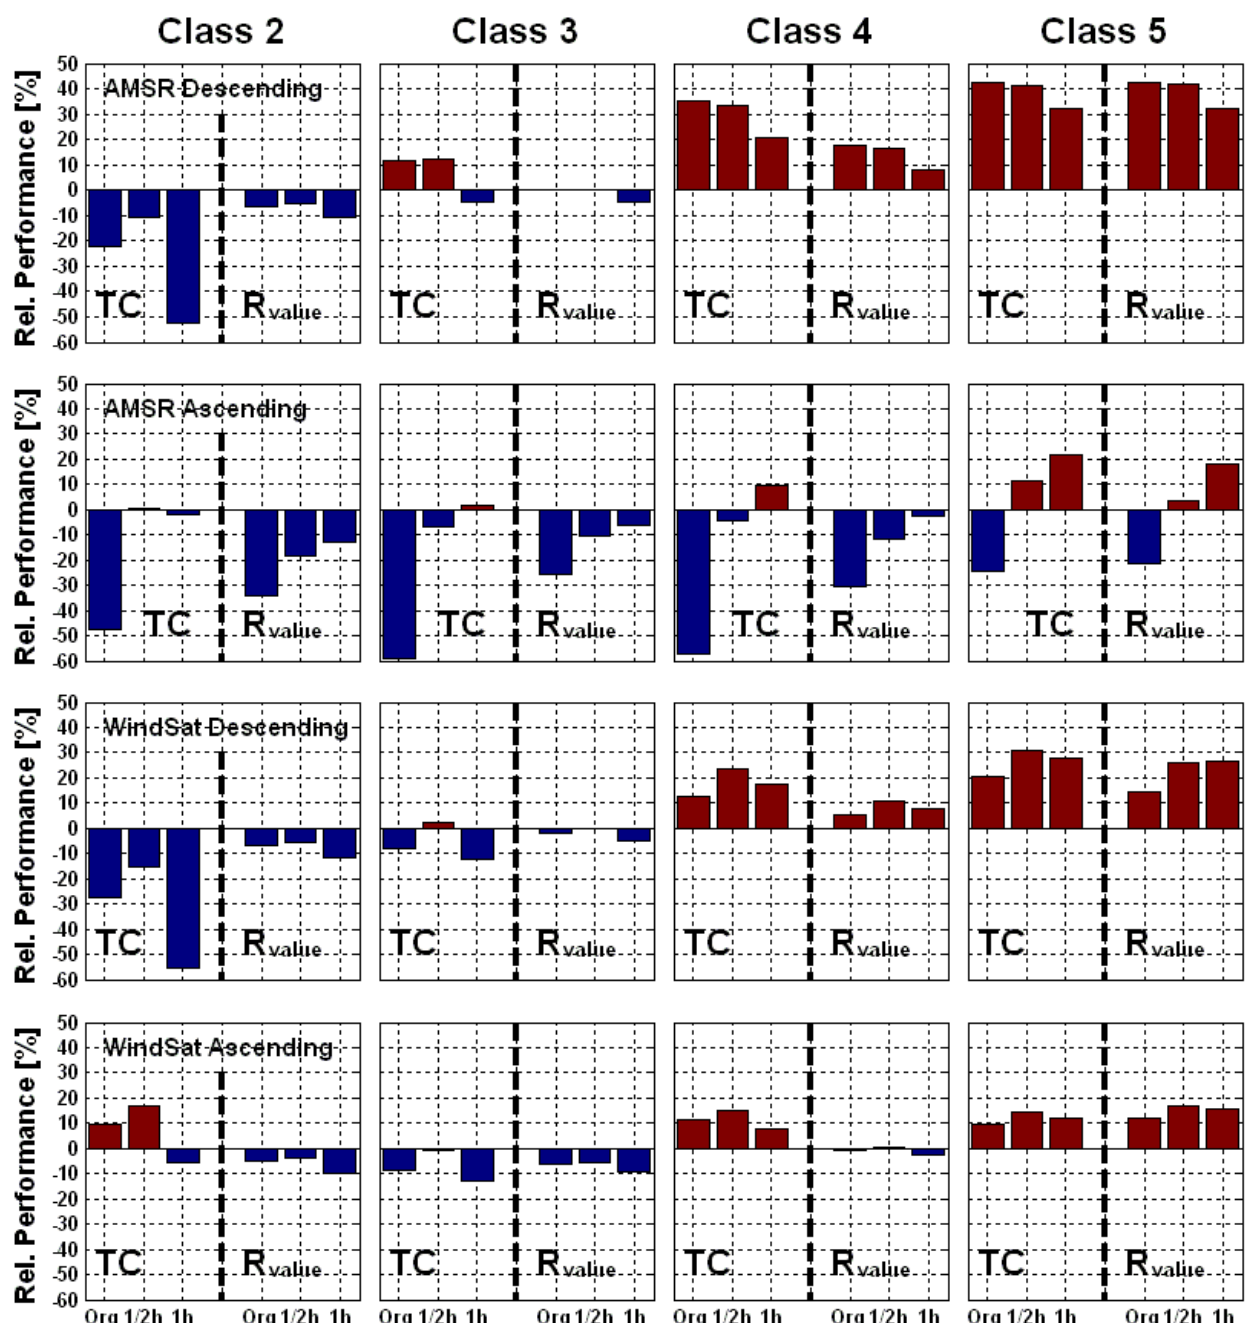
Fig. 9. The relative skill in anomaly detection according to the TC and R value techniques for three T MERRA scenarios representing dif- ferent soil depths. The x-axis represents the different MERRA scenarios (Original, 1/2h- and 1h phase shift), and the y-axis captures the improvements (red) or degradation (blue) relative to the baseline case. Each row shows the results for a different observation time as based on AMSR-E (01:30a.m./p.m.) and WindSat (06:00a.m./p.m.). The results are further subdivided based on vegetation classes 2–5 (Table